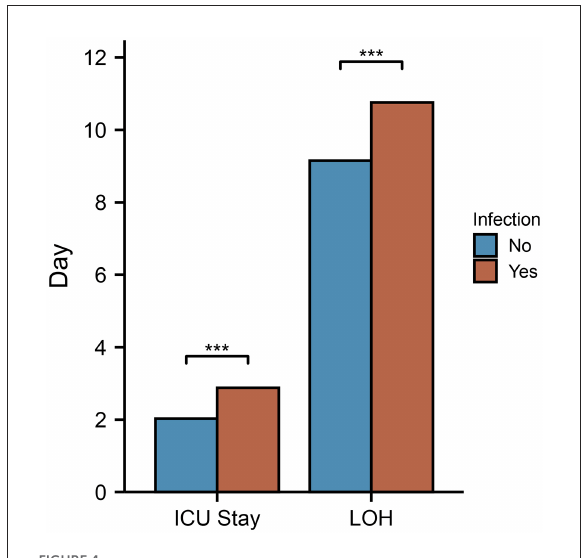
FIGURE4 Compared between infected and non-infected patients, duration of ICU stay and hospitalization. In the infected group, the hospital stay and ICU stay were longer than in the non-infected